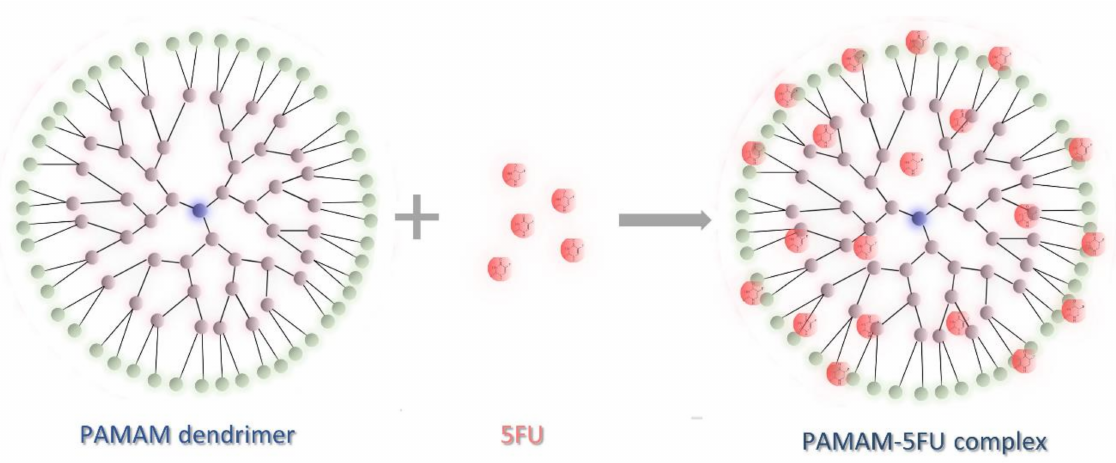
Figure 2. Schematic illustration of PAMAM dendrimer/5-fluorouracil complex formation.